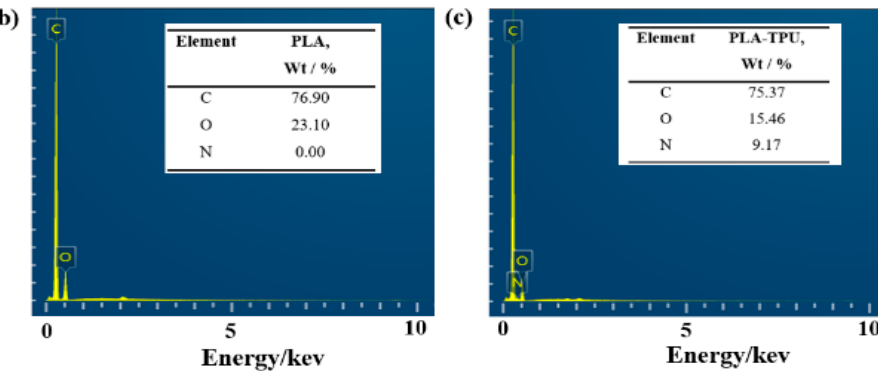
Figure 4. ( a ) FTIR spectrum of the control and composite membranes with various TPU thickness; EDS spectrum of ( b ) the control and ( c ) PLA-TPU-16 composite membranes.